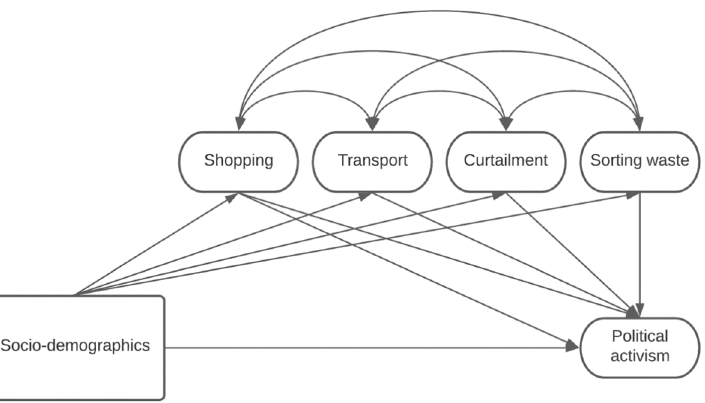
Figure 2. Path model. Political activism serves as fully endogenous variables and socio-demographics as fully exogenous variables. Pro-environmental behavior is used to explain political activism, while being explained by socio-demographics. Covariances between types of pro-environmental behavior are also included.